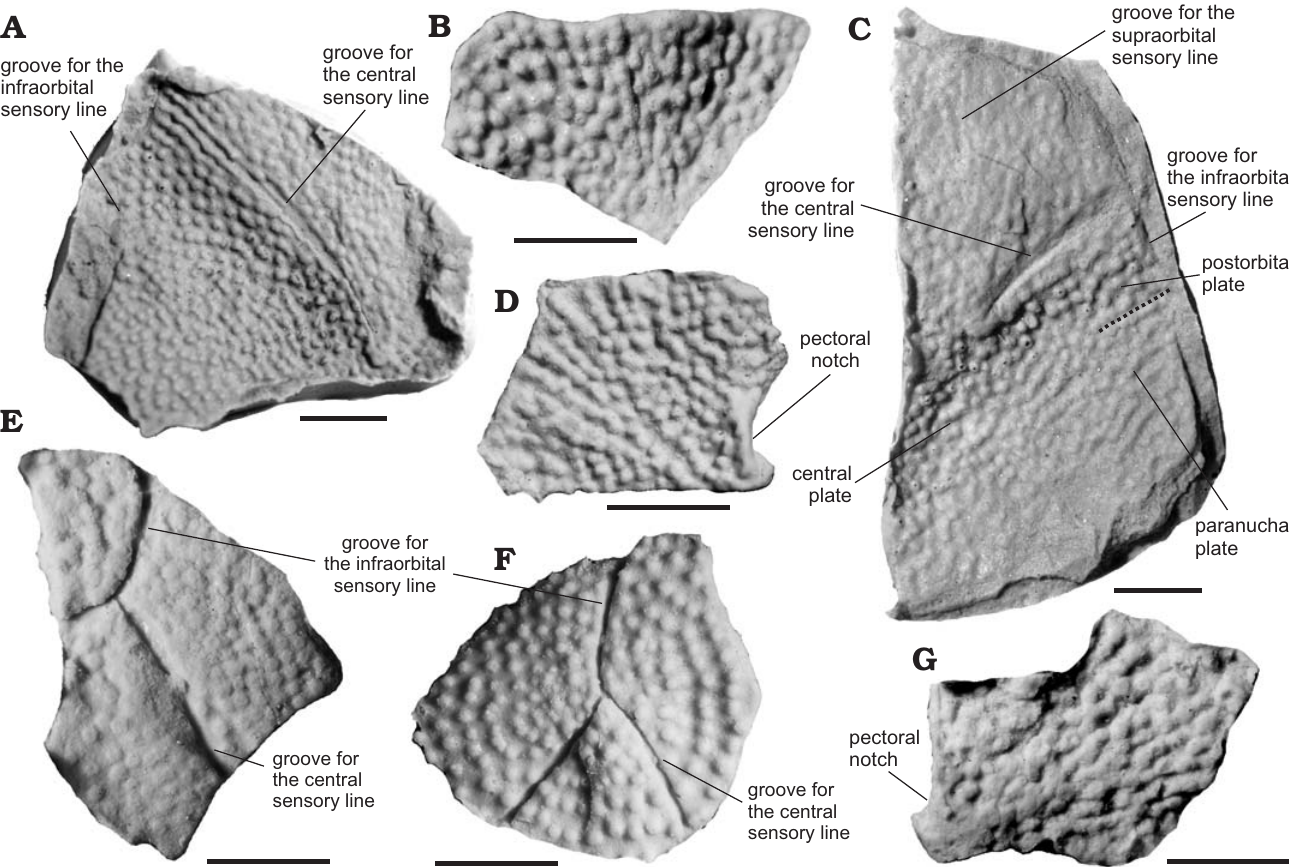
Fig. 3. Cranial and thoracic material of arthrodiran placoderm Kujdanowiaspis sp. (A, C, E, F) and Erikaspis sp. (B, D, F) from Lower Devonian (Emsian) of Pod ł azie Hill, Holy Cross Mountains, Poland. A . MZ-VIII/Vp-340, left fragmentary skull roof. B . MZ-VIII/Vp-480, posterodorsal fragment of a